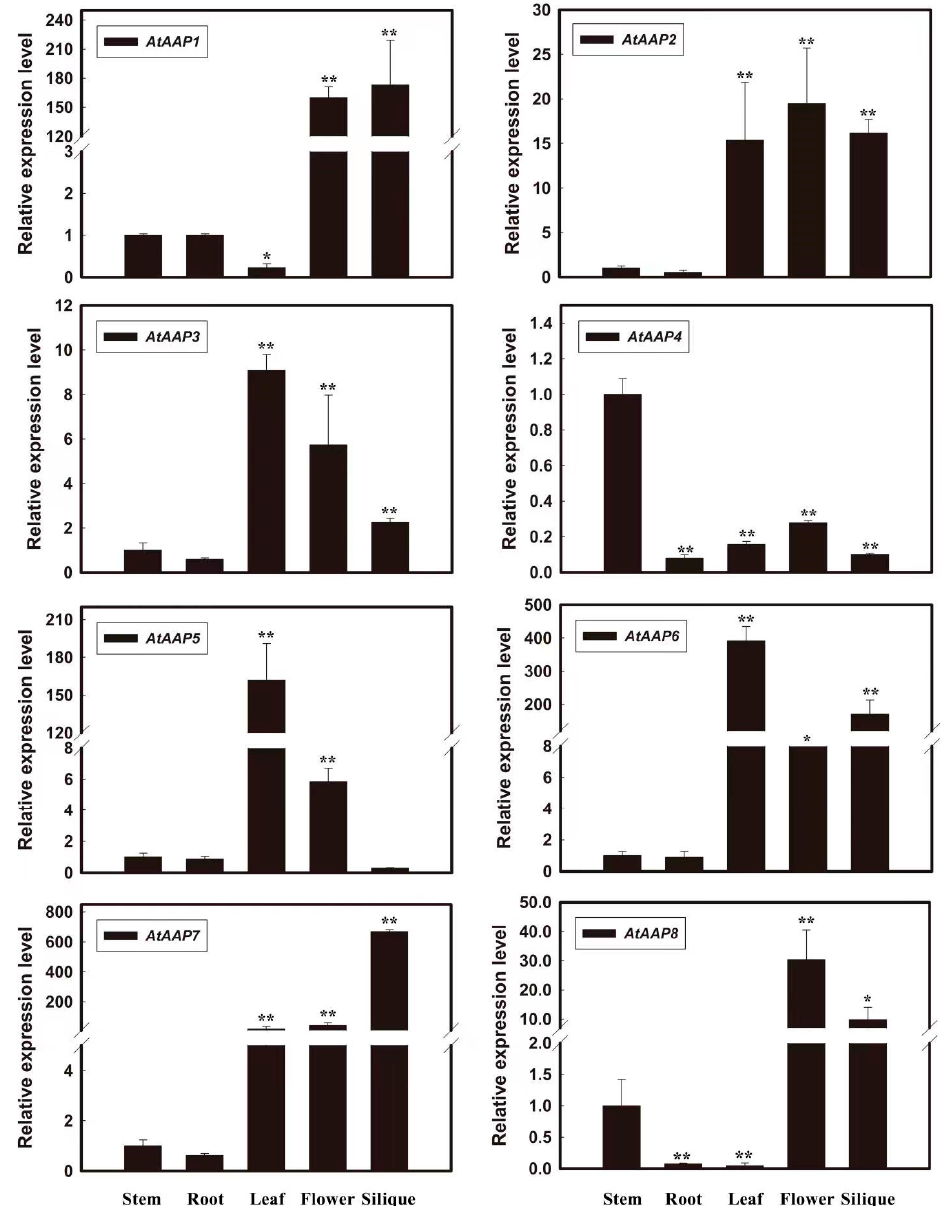
Figure 3. Relative expression patterns of eight AtAAP genes in different tissues of wild-type (WT) Arabidopsis thaliana based on qRT-PCR analysis with actin gene as the internal reference gene. Symbols “*” and “**” indicate the significant differences in comparison to stems at p values of 0.05 and 0.01, respectively.